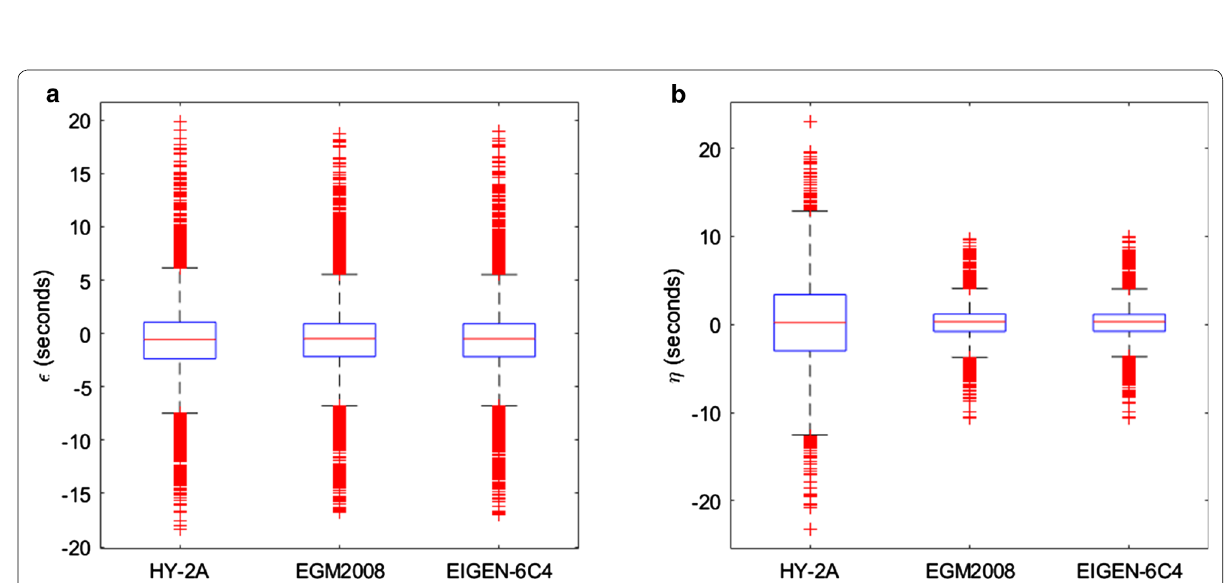
Fig. 6 Dispersions of a North and b East components of vertical